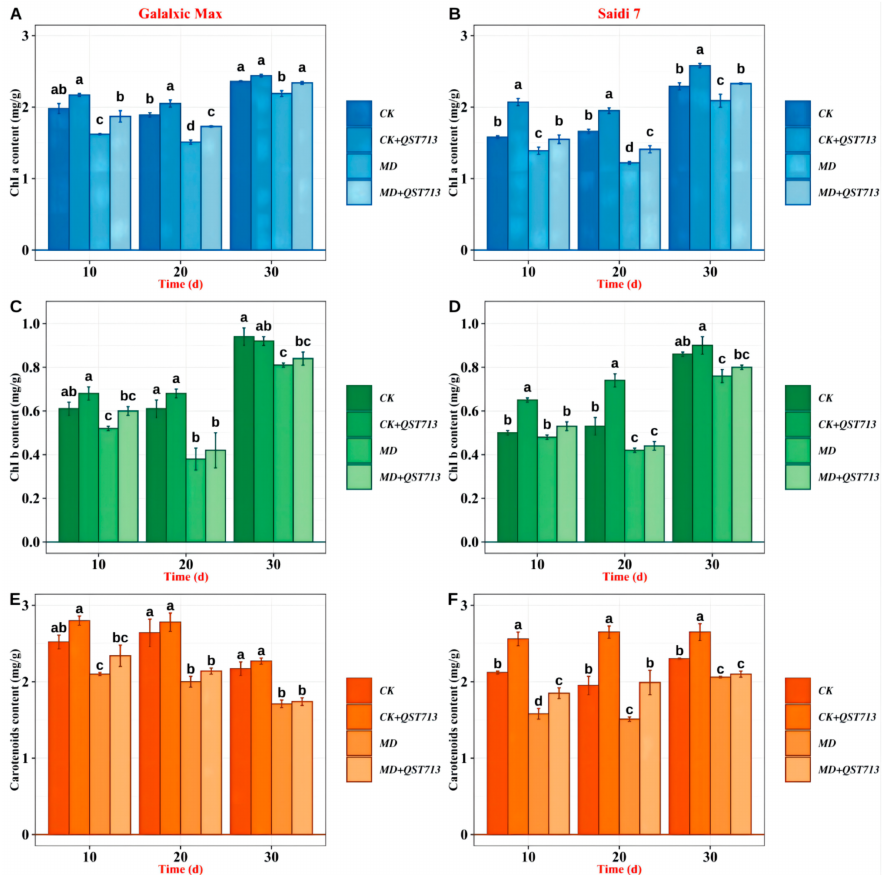
Figure 3. Effect of drought stress and QST713 application on the content of Chl a ( A , B ), Chl b ( C , D ) and carotenoids ( E , F ) of alfalfa seedlings in two cultivars (( A , C , E ), Galalxic Max; ( B , D , F ), Saidi 7). Data are the mean ± SE ( n = 3). Different letters indicate significant differences from each other ( p <